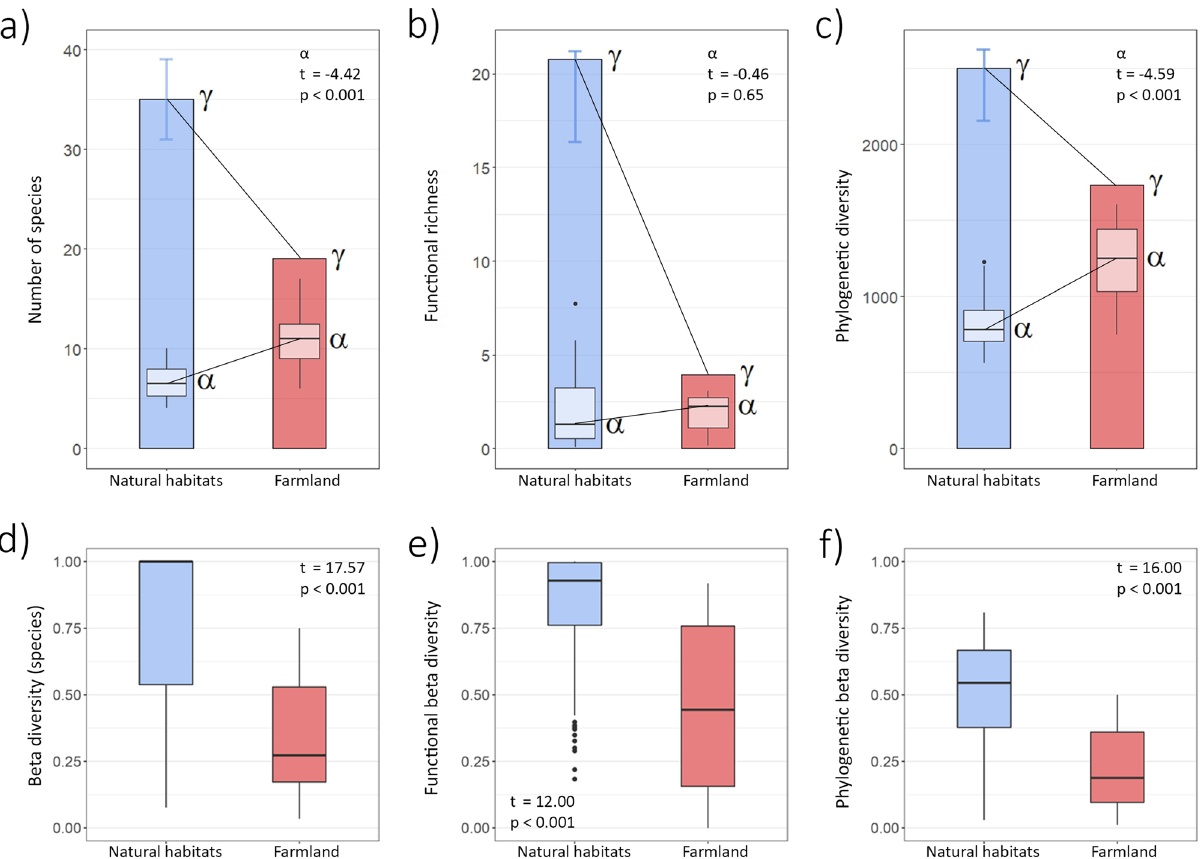
Figure 1. Alpha and gamma diversity ( a – c ) and pairwise beta diversity ( d – f ) of amphibian communities in natural habitats (natural forest, natural savannah; blue) vs farmland (red) across Rwanda. Diversity is measured as ( a , d ) taxonomic diversity (number of species), ( b , e ) functional diversity (functional richness), and ( c , f ) phylogenetic diversity (Faith’s PD) both on the level of local communities (alpha diversity) and once pooled across Rwanda (gamma diversity). Gamma diversity is shown as colored bars; median and standard deviation of local alpha diversity (n = 15) are shown as lighter boxplots within bars. Gamma diversity in natural habitats represents the median of 1000 sampled combinations of seven and eight forest and savannah sites; error bars indicate observed range. Alpha diversity was consistently higher in farmland than in the natural habitat, whereas gamma diversity was consistently higher in natural sites than in farmland ( a – c ). Correspondingly, beta diversity was consistently higher in natural sites than in farmland ( d – f